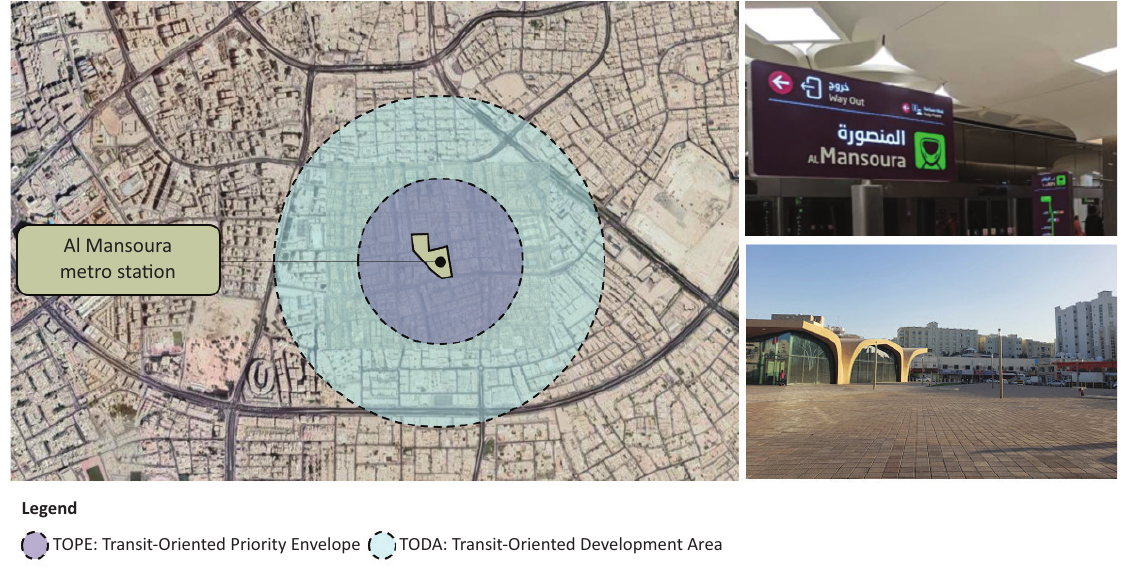
Figure 3. The study site, with Al Mansoura metro station at its